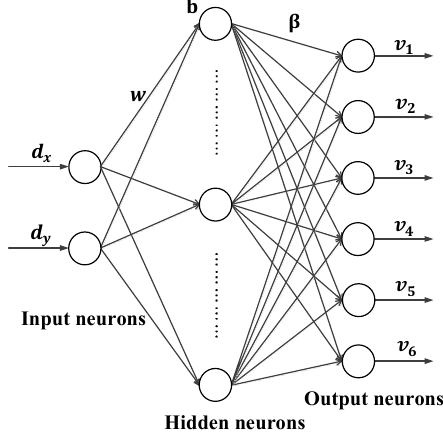
Figure 3. SLFN ( single-hidden layer feedforward neural network ) structure of the 2D to 6D Figure 3. SLFN (single-hidden layer feedforward neural network) structure of the 2D to 6D mapping.